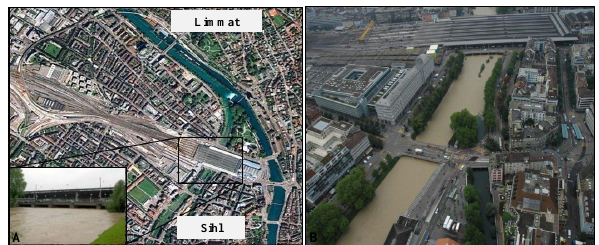
Figure 2. Sihl River flowing beneath Zurich main train station before the confluence with the Limmat River: (a) from Google Maps; in the inset, the situation in August 2005 during a flood event, source: A. Senn (WSL). (b) Sihl River flowing under- neath the Zurich main train station in August 2005 (discharge: 280m 3 s − 1 ), source: Office of Waste, Water, Energy and Air, Zürich (M.